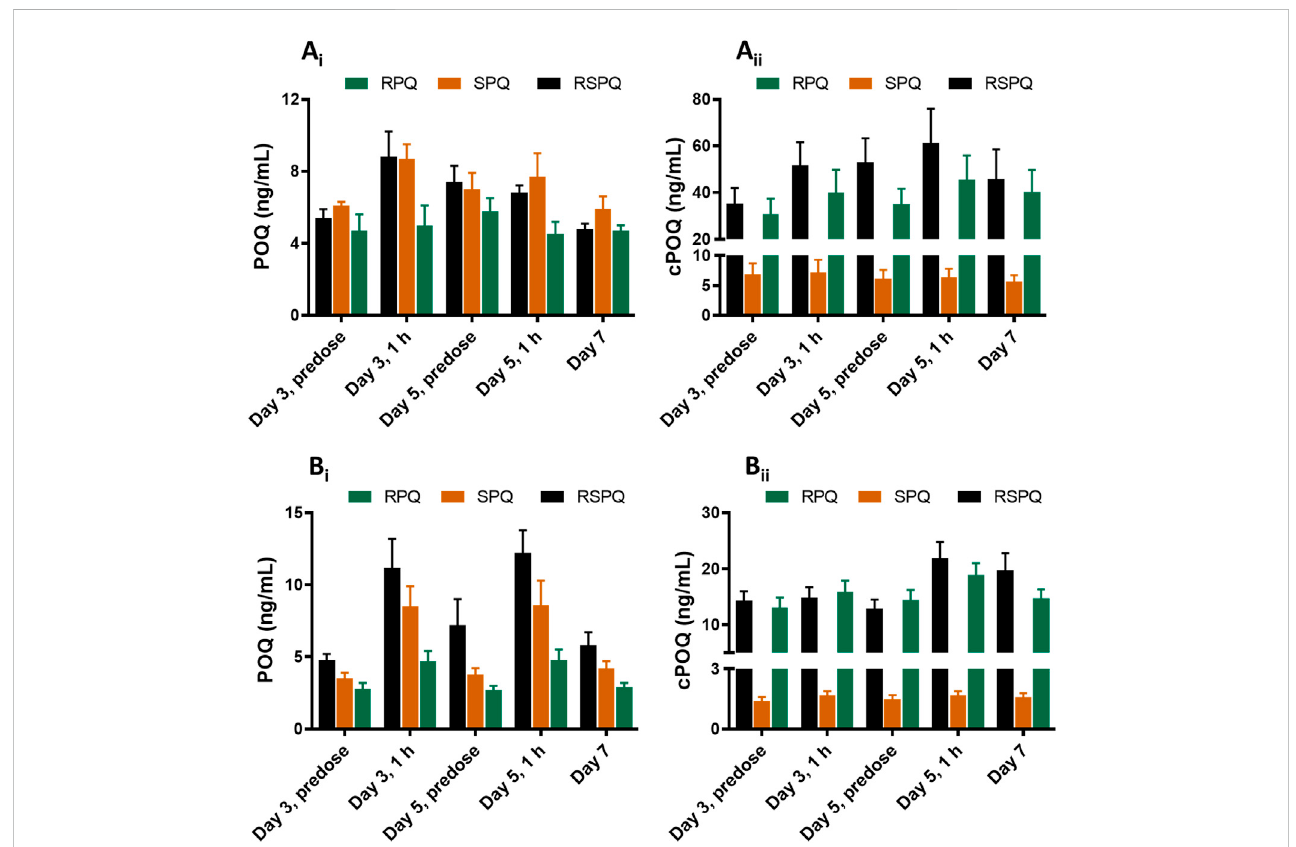
Concentrations of ortho-quinone metabolites of PQ in plasma (Ai and Aii) and RBCs (B i and B ii ) of G6PDn subjects during oral administration of PQ enantiomers or racemate for 7 days. Bar graphs are presented as mean with SEM (N =